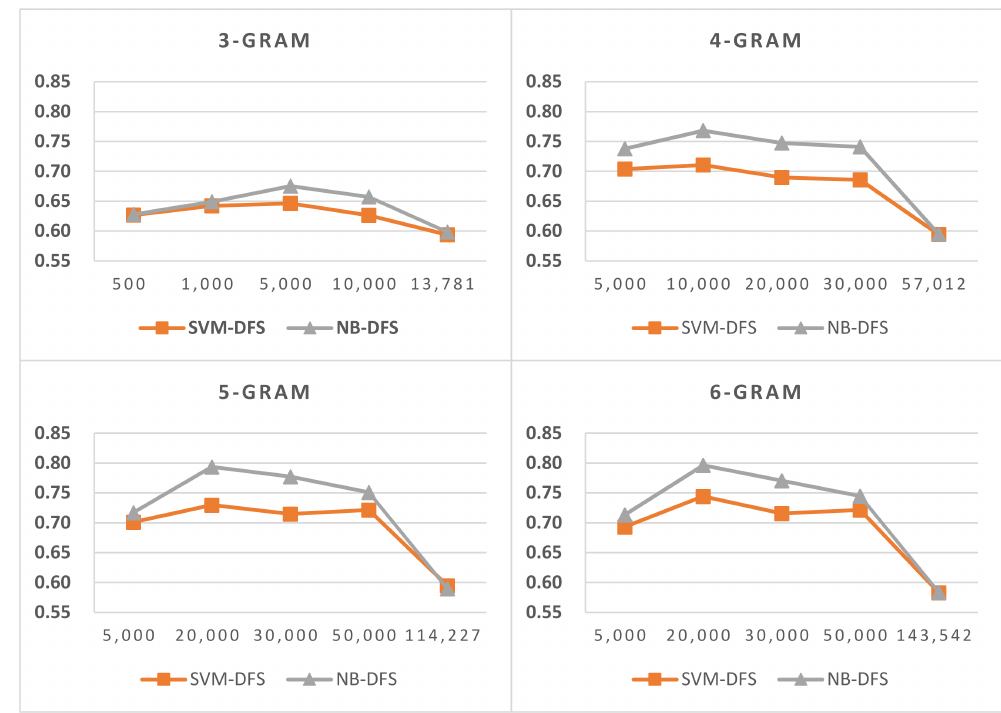
Figure 14. LI in SLG consisting of nob and